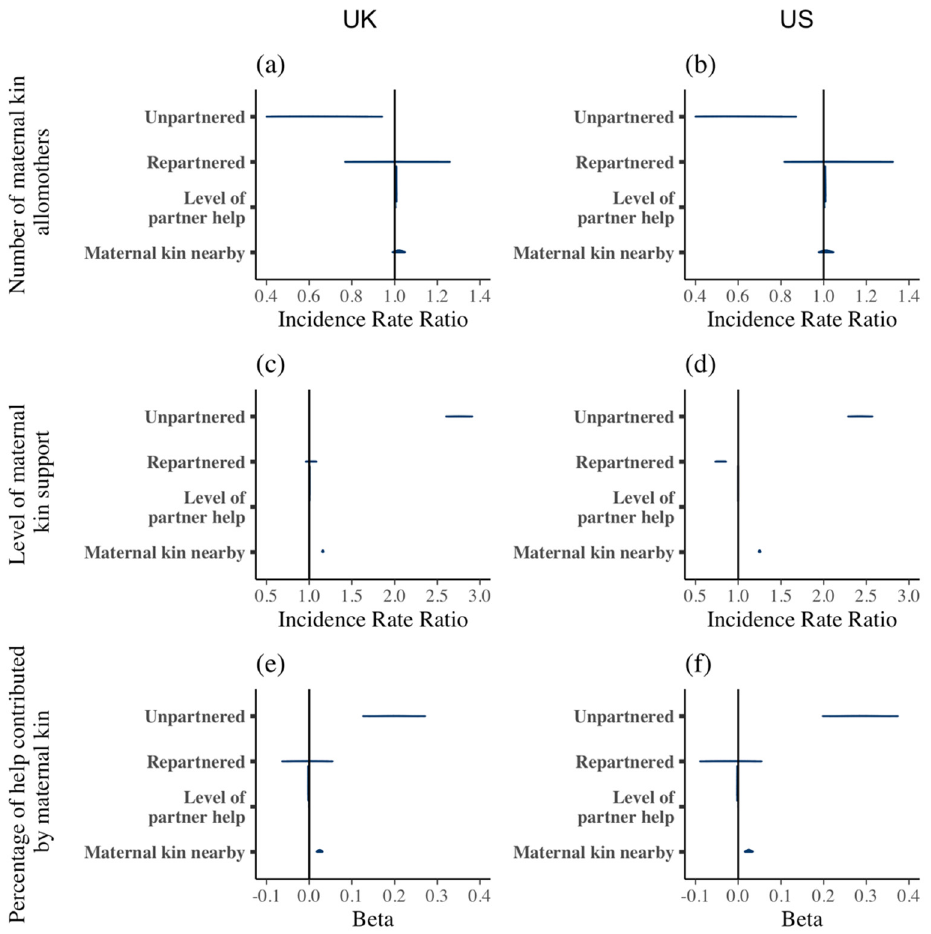
Figure 2. Plots showing the posterior distributions (95% credibility intervals) for the major predictors and control variables in the models for maternal kin allomother investment in each country, using the following measures: ( a , b ) number of maternal kin providing childcare; ( c , d ) total level of childcare help provided by maternal kin; and ( e , f ) percentage of total childcare help contributed by maternal kin. Reference category for unpartnered and repartnered women is partnered women; level of partner help and maternal kin nearby are entered as continuous predictors.